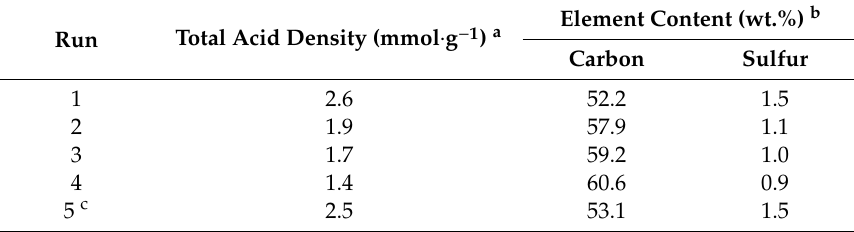
Table 1. Total acid density and elemental content of the reclaimed